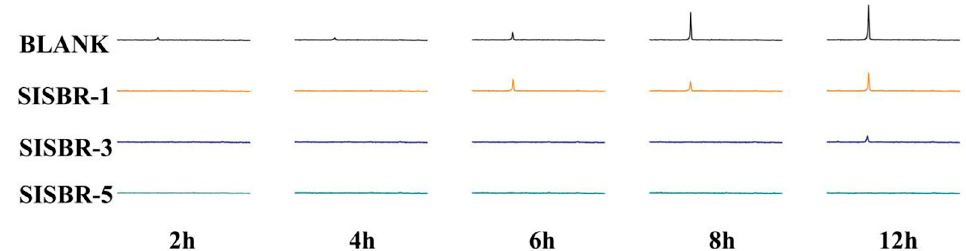
Figure 10. Time-dependent evolution of the CH signal (2 θ = 18.01°) of the hydrating cement pastes with SISBR latex powder measured via XRD.